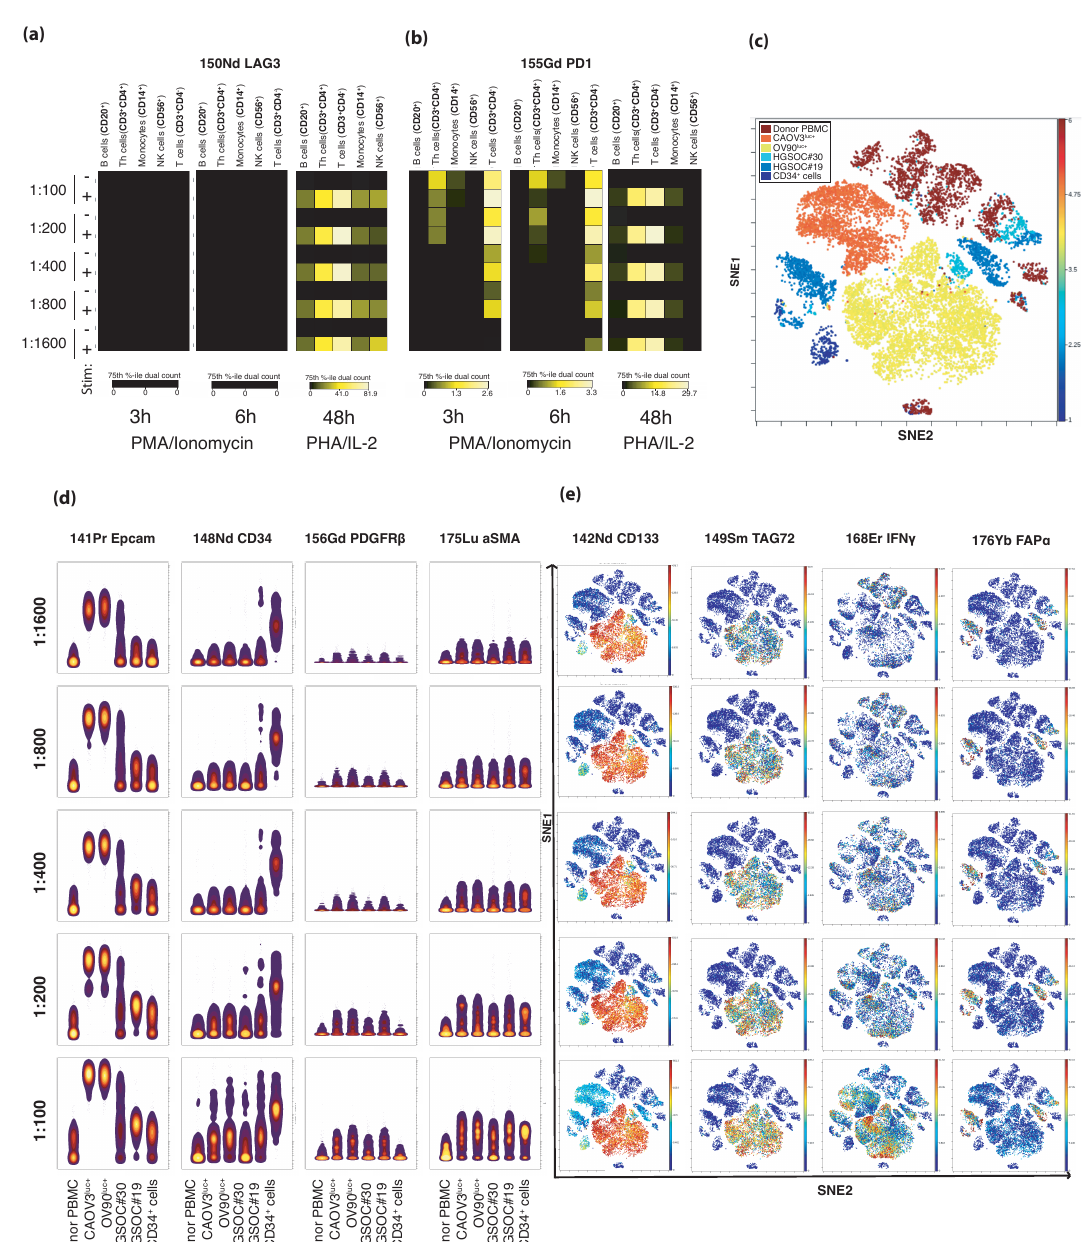
Figure 1. Titration of the panel antibodies using Cytobank software. ( a , b ) Immune checkpoint antibodies were titrated on both peripheral blood mononuclear cells (PBMCs) stimulated by phorbol 12-myristate 13-acetate (PMA) (25 ng/mL) + ionomycin (1 µ g/mL) and PBMCs stimulated by phytohemagglutinin (PHA) (2.5 µ g/mL) + interleukin 2 (IL-2). Heatmaps show that LAG-3 ( a ) was only expressed after stimulation by PHA/IL-2 and that PD-1 expression ( b ) differed with the dilution in the cells stimulated by PMA/ionomycin, while expression was consistent across all dilutions tested on PHA/IL- 2-stimulated cells. ( c ) A viSNE plot was generated after pooling all samples from the stromal marker and tumor cell marker titration experiments, and the different samples were color coded. The results demonstrate a distinct separation of ovarian cancer cell lines (Caov-3 and OV-90) from the other samples, while the two dissociated tumor samples (HGSOC#19 and HGSOC#30) and the stem cells (CD34+ cells) show overlapping phenotypes, as well as some cellular similarity with the healthy donor sample (donor PBMCs). ( d ) Illustration of the gating strategy of the concatenated .fcs files to visualize immune staining. Plots display the sample-wise staining pattern in six samples (in the columns) of four selected markers, two tumor (EpCAM and CD34) and two stromal (PDGFRß and α SMA) antibodies (horizontally) in a dilution series from 1:100 to 1:1600 (vertically). ( e ) The viSNE plot in ( c ) color coded according to the specific antibody expression of four antibodies (horizontally) in the combined samples according to titration levels (vertically), from the most diluted on the top to the least diluted on the